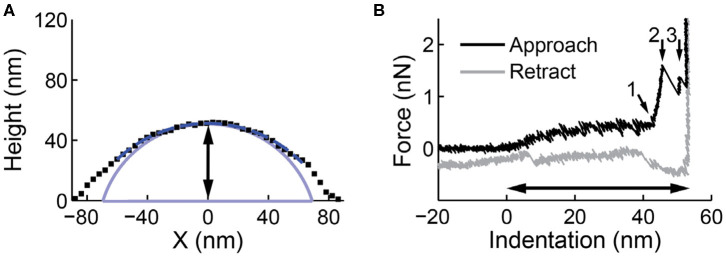
Line profile and nanoindentation on a liposome. (A) A line profile along the slow scanning axes through the maximum of the particle. A circular arc is fitted to the upper half of the line profile (dashed dark blue). The spherical cap shape after deconvolution is shown in light blue. The black arrow indicates the height derived from the image (51.9 nm). (B) A force indentation curve on the same particle. The contact point between the tip and the vesicle is set at 0 nm indentation. At around 45 nm, marked by small arrow 1, the two bilayers are pressed together. After two discontinuities (small arrow 2 and 3), the glass surface, which appears infinitely stiff, is reached. The black arrow indicates the height derived from the indentation curve (55.6 nm), which is a more accurate (and typically larger) estimate than the height estimation from the profile in (A).